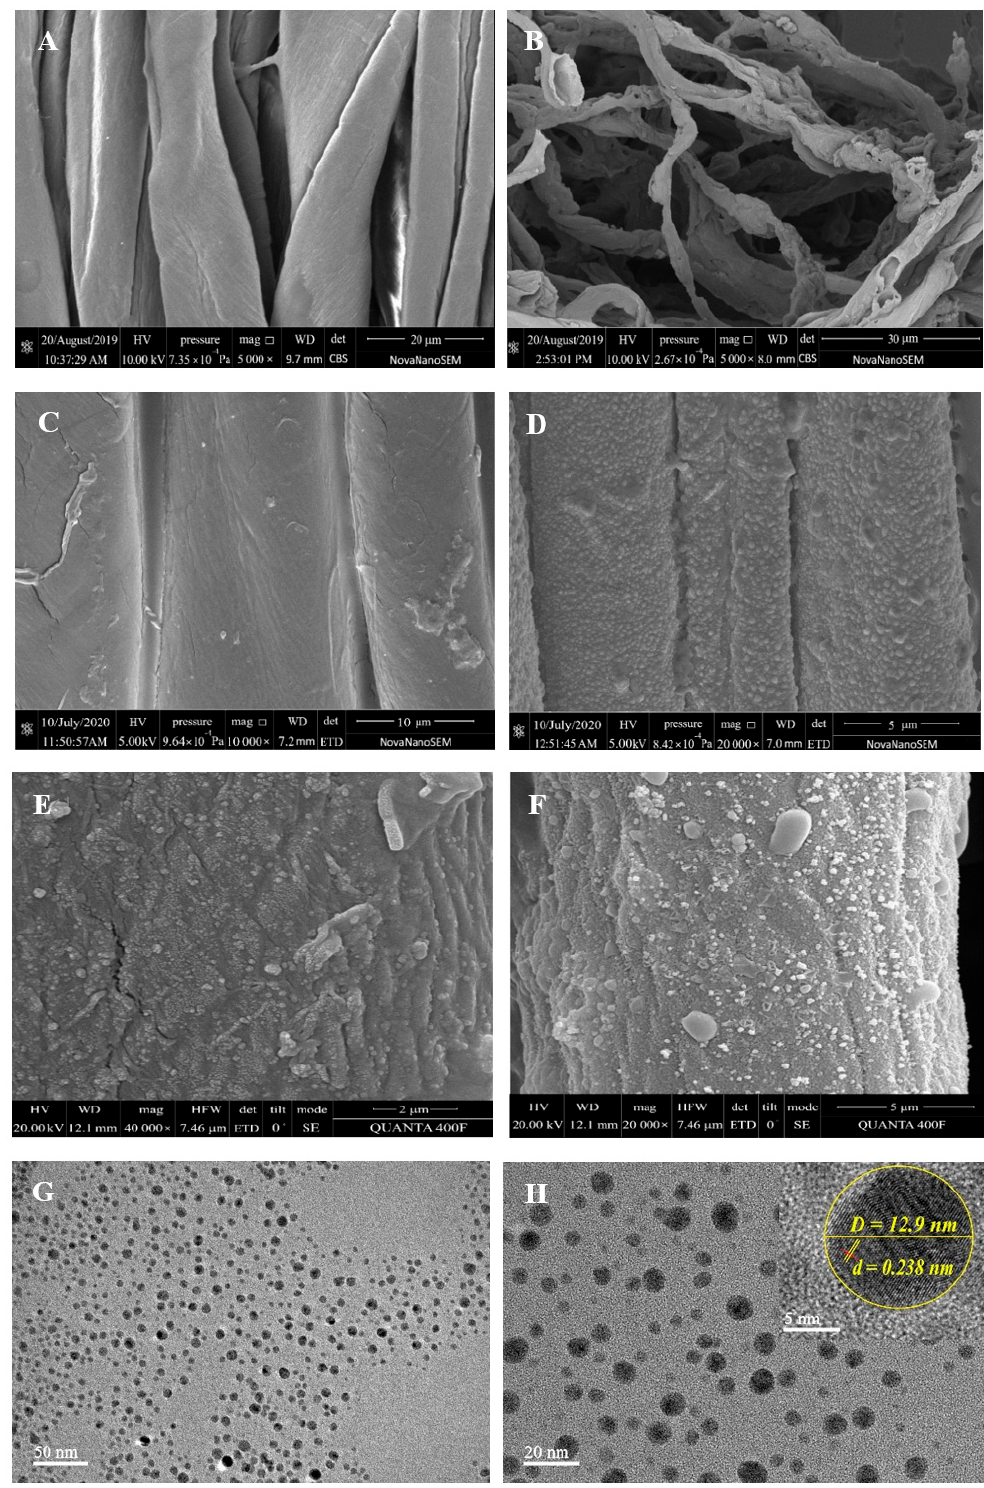
Figure 3. The SEM spectrogram of fabrics and TEM spectrogram of Ag. ( A ): O-C before burning; ( B ): O-C after burning; ( C ): PP-C before burning; ( D ): PP-C after burning; ( E ): PPA-C before burning; ( F ): PPA-C after burning; ( G , H ): different multiples of TEM.